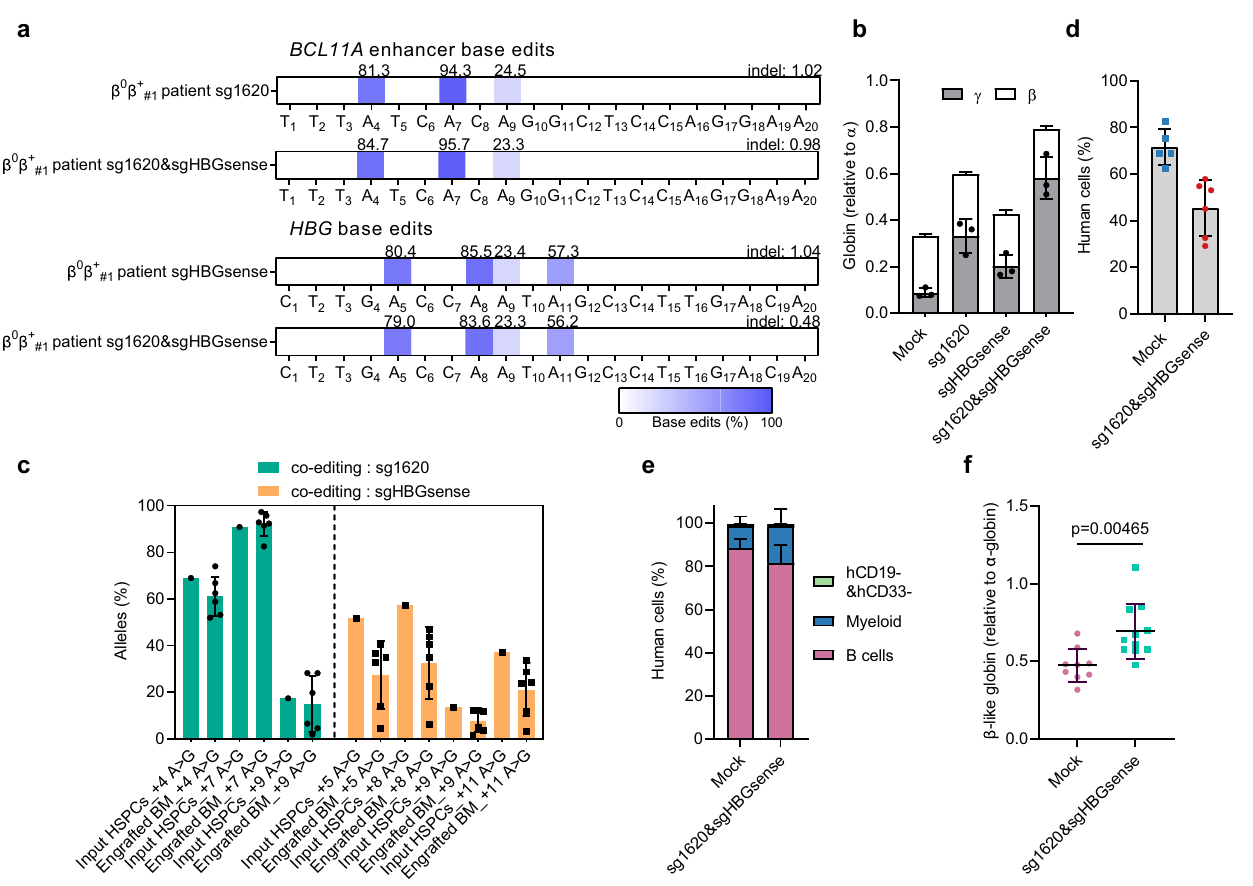
Fig. 3 | Therapeutic and multiplex base editing in β -thalassemia patient CD34 + HSPCs.a BaseeditingbyABE8eat+58 BCL11A enhancerwithsgRNA-1620(toptwo rows) and HBG promoter by sgHBGsense (bottom two rows) after single or mul- tiplexeditingin β -thalassemiadonor( β 0 β + #1 patient). b β -likeglobinexpressionby RT-qPCR normalized by α -globin, measured from edited erythroid progeny. Data areplottedasmean±sd. n =3replicatesfromindependentdifferentiationcultures. c Base editing in unfractionated BM after 16 weeks as compared to input HSPCs. Data are plottedasmean±sd. n =6 primary recipients foreachgroup of engrafted HSPCs. d Human BM chimerism analyzation 16 weeks after base edited HSPC